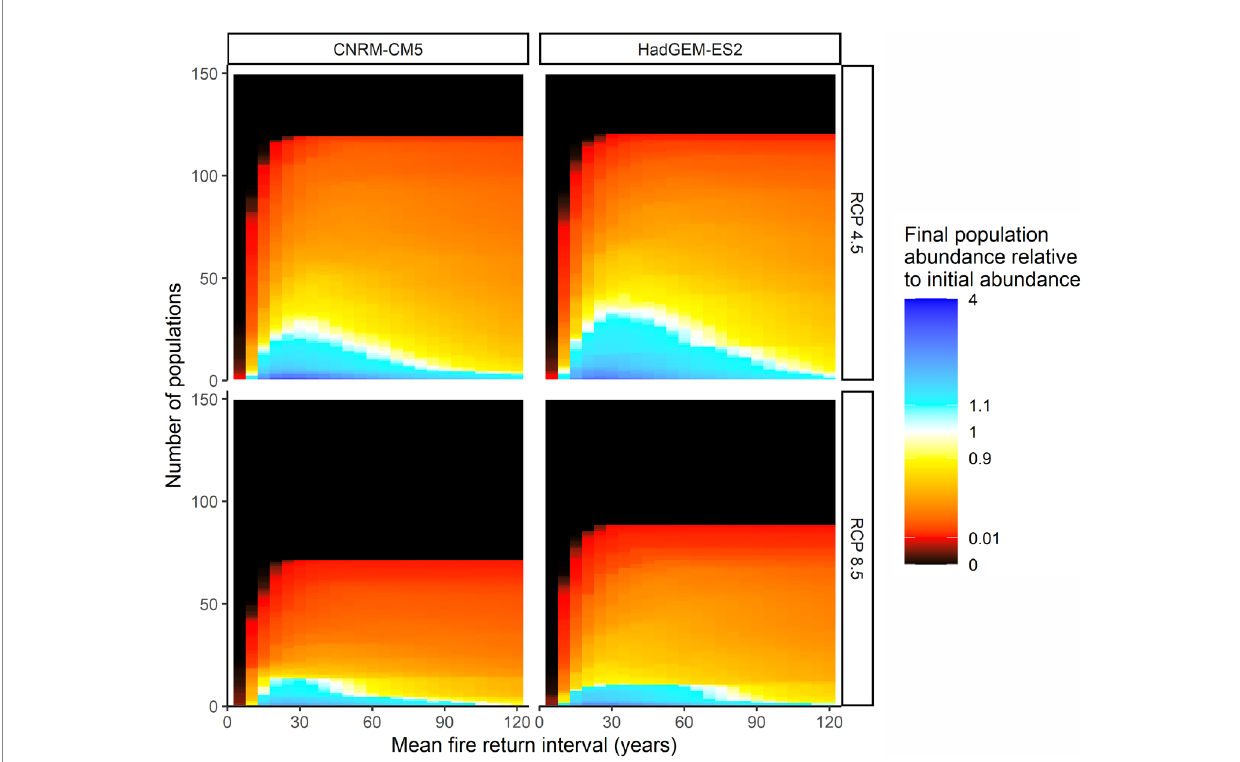
FIGURE 3 Final abundance of each of the 149 different subpopulations relative to the initial abundance of those subpopulations across different mean fire return intervals under spatially explicit fire frequency distributions. Individual subpopulations are stacked such that subpopulations that increase in abundance are at the bottom, while subpopulations that decrease in abundance or go locally extinct are at the top. Climate models and emissions scenarios are arranged in columns and rows, respectively.